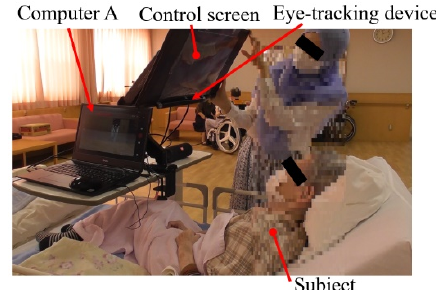
Figure 5. Patient (Hospital).